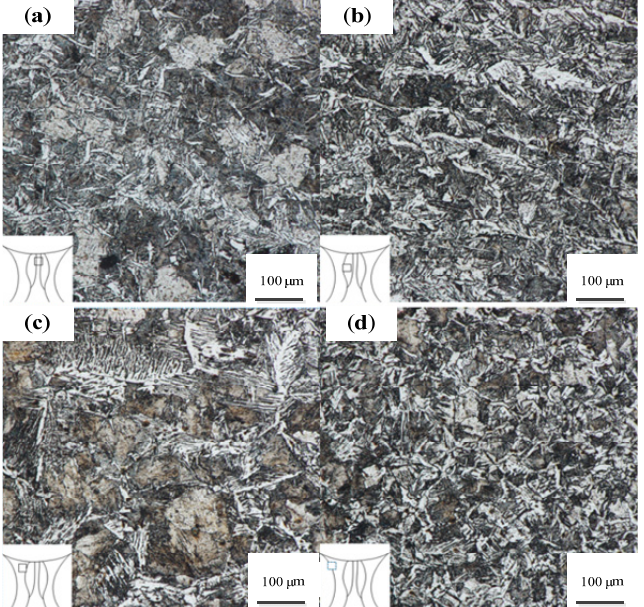
Figure 12. Weld microstructure: ( a ) weld center microstructure, ( b ) fusion zone microstructure, ( c ) coarse-grained microstructure of heat-affected zone, ( d ) fine-grained microstructure of heat-affected zone. heat-affected